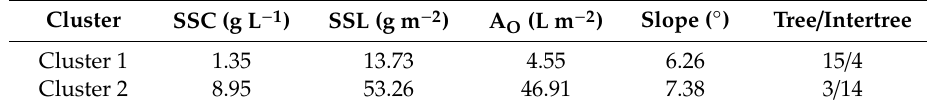
Table 3. Means of the inputs for the two-step cluster analysis in order of predictor influence. A tree / intertree column was separately added to indicate potential cluster predominance by tree or intertree area. Parameters are suspended sediment concentration (SSC), suspended sediment load (SSL), surface runo ff (A O ), and